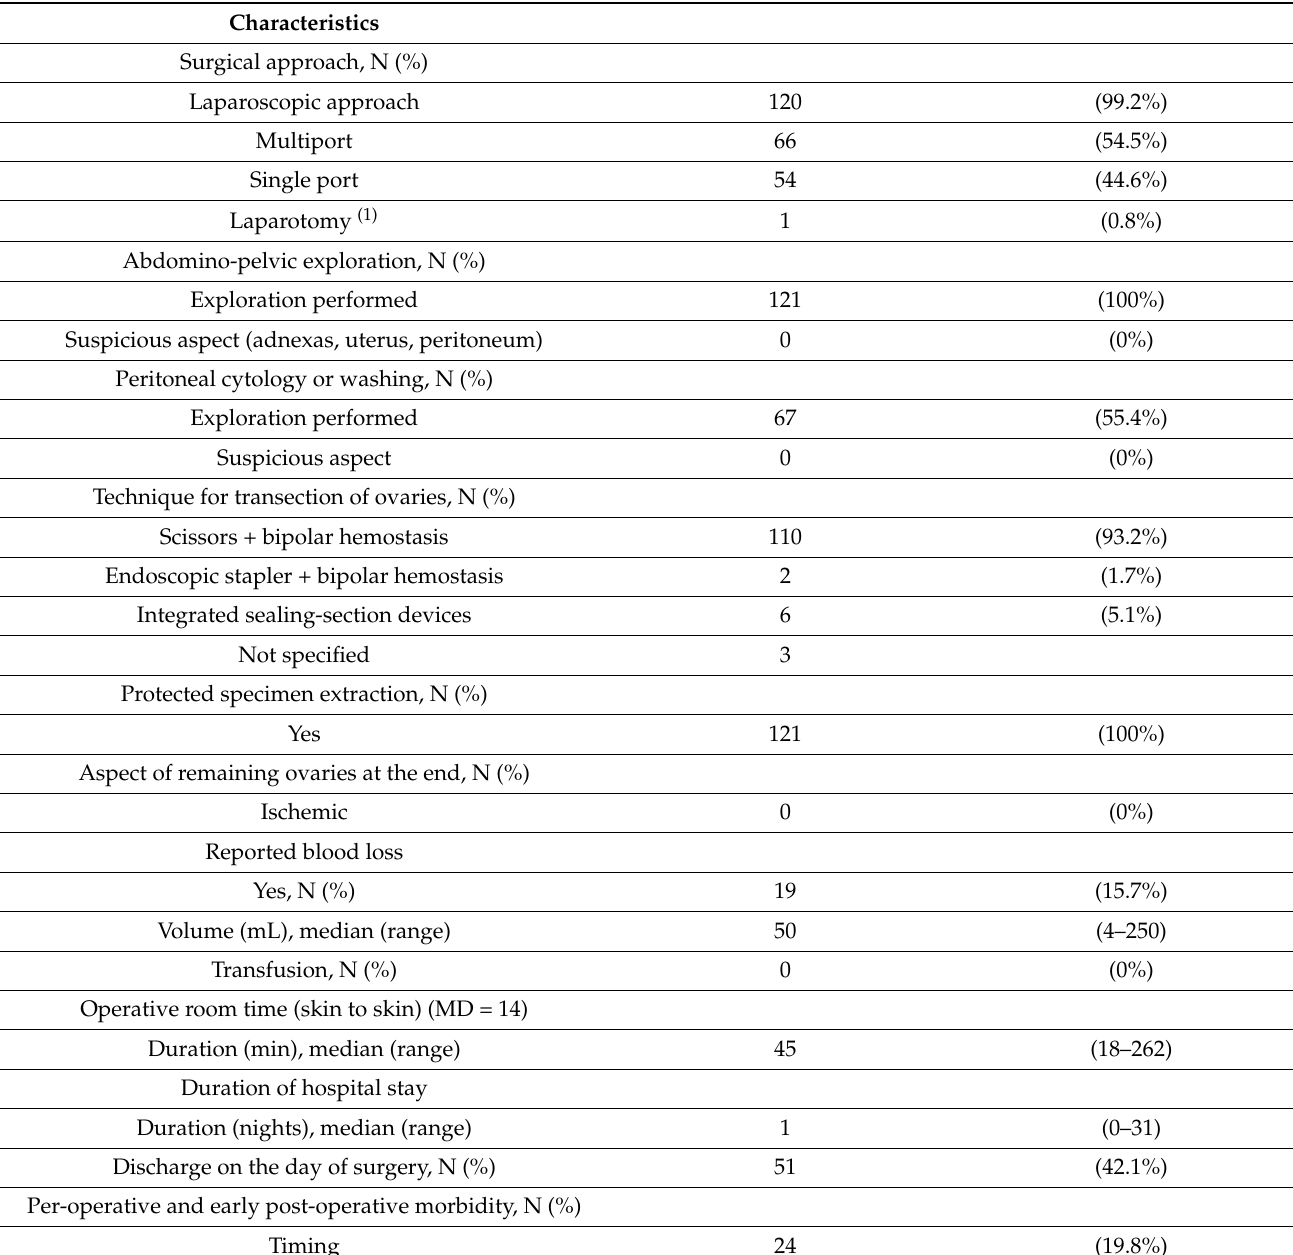
Table 2. Radical fimbriectomy—surgical data and morbidity (N =